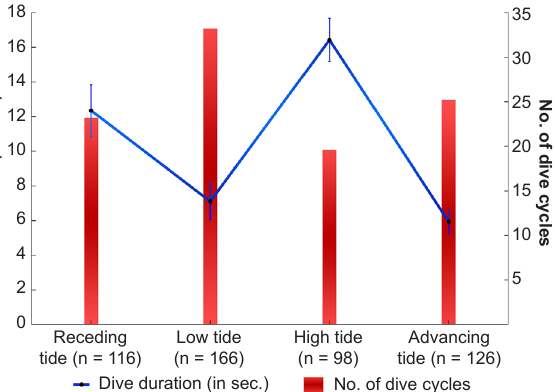
Figure 2. Relationship between number of dive cycles and dive